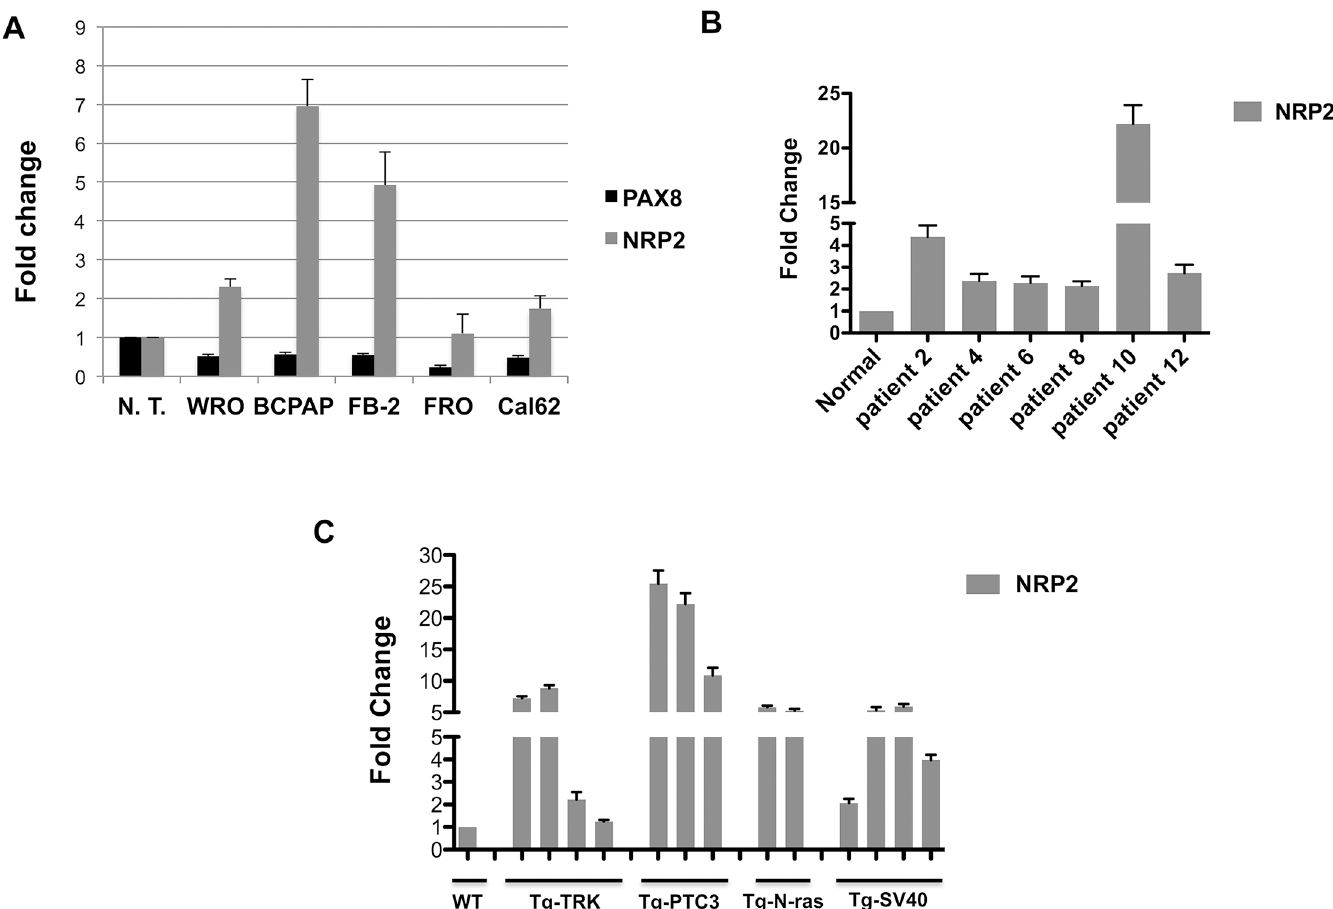
Fig 2. NRP2 expression in experimental models of thyroid carcinogenesis. (A) NRP2 and PAX8 expression was measured by qRT- PCR in five human thyroid cancer cell lines: WRO from follicular thyroid cancer, FB-2 and BCPAP from papillary thyroid carcinoma, Cal62 and FRO from anaplastic thyroid carcinoma. RNA from six non-pathological thyroids was used as control. ABL1 was used as reference gene; results are reported as 2 - Δ Ct . Statistical analysis uses t-test (p (cid:3) 0.05). (B) qRT-PCR analysis was performed on total RNA prepared from 6 tissue specimens of PTC. A pool of six normal thyroid tissues (N. T.) was used as control. Statistical analysis uses t-test (p (cid:3) 0.05). (C) qRT-PCR analysis was performed on total RNA prepared from thyroid carcinomas developed in Tg-TRK, Tg-PTC3, Tg-N-ras and Tg-SV40 transgenic mice expressing TRK, RET/PTC3, N-ras and SV40 T-antigen under the transcriptional control of the Tg promoter. Relative quantities of NRP2 mRNA were normalized to cyclophilinA as reference gene. Each amplification was performed in duplicate and the data are expressed as fold change with respect to the normal mouse thyroid tissues used as a control, whose value was set at 1.0. Statistical analysis uses t-test (p (cid:3)